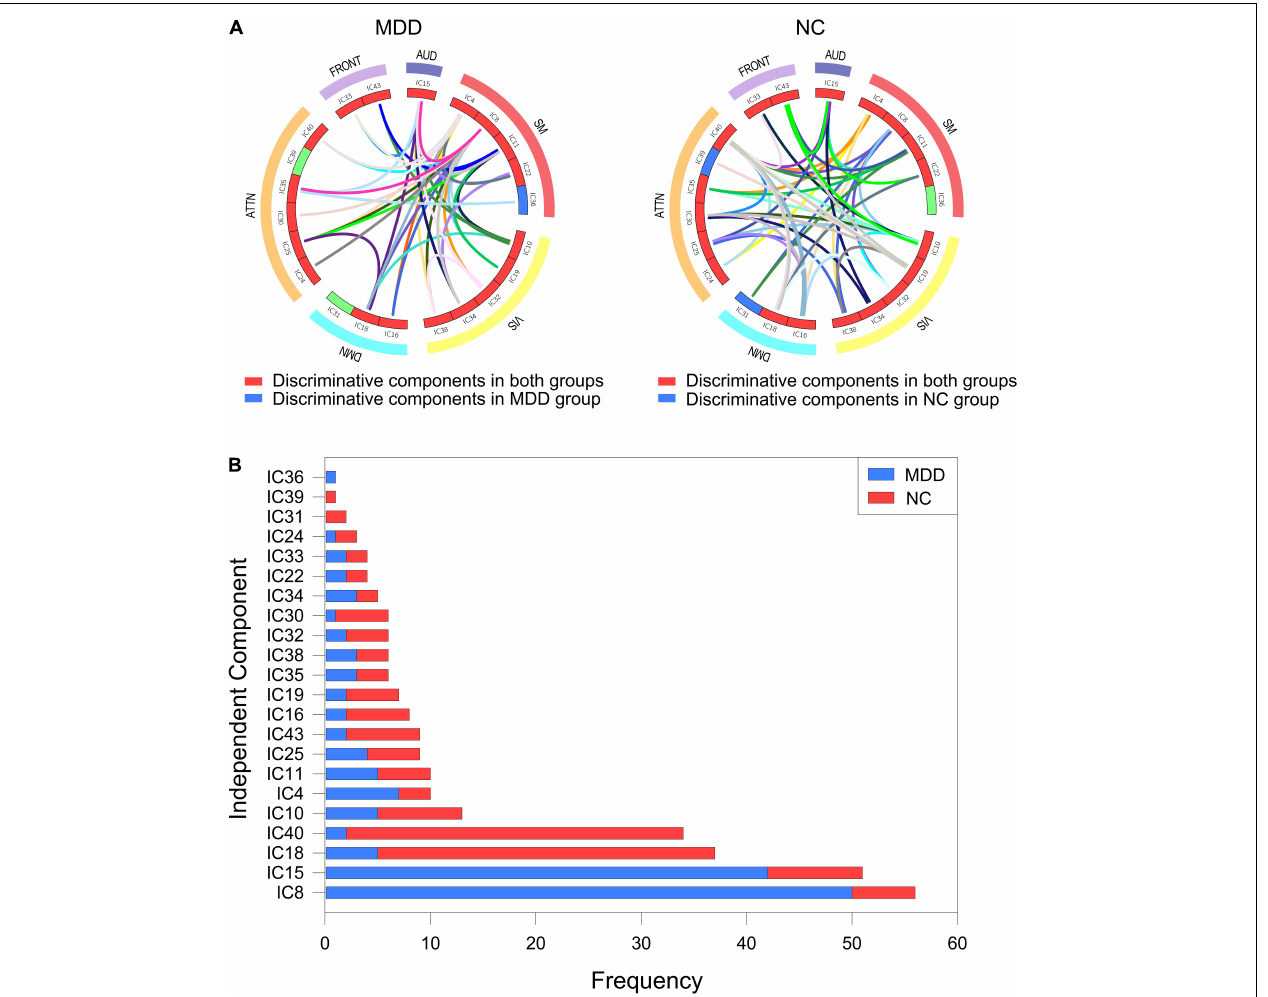
FIGURE 6 | Discriminative components of the discriminate subgraph features. AUD, auditory network; SM, sensorimotor network; VIS, visual network; DMN, default mode network; ATTN, attentional network; FRONT, frontal network. IC, independent component. (A) All discriminative subgraphs were combined in each group. Left figure represents all discriminative components of the discriminate subgraph features in MDD group. Right figure represents all discriminative components of the discriminate subgraph features in NC group. (B) A statistical chart showing the frequencies of the independent components in two groups of subjects. Red represents MDD group; Blue represents NC